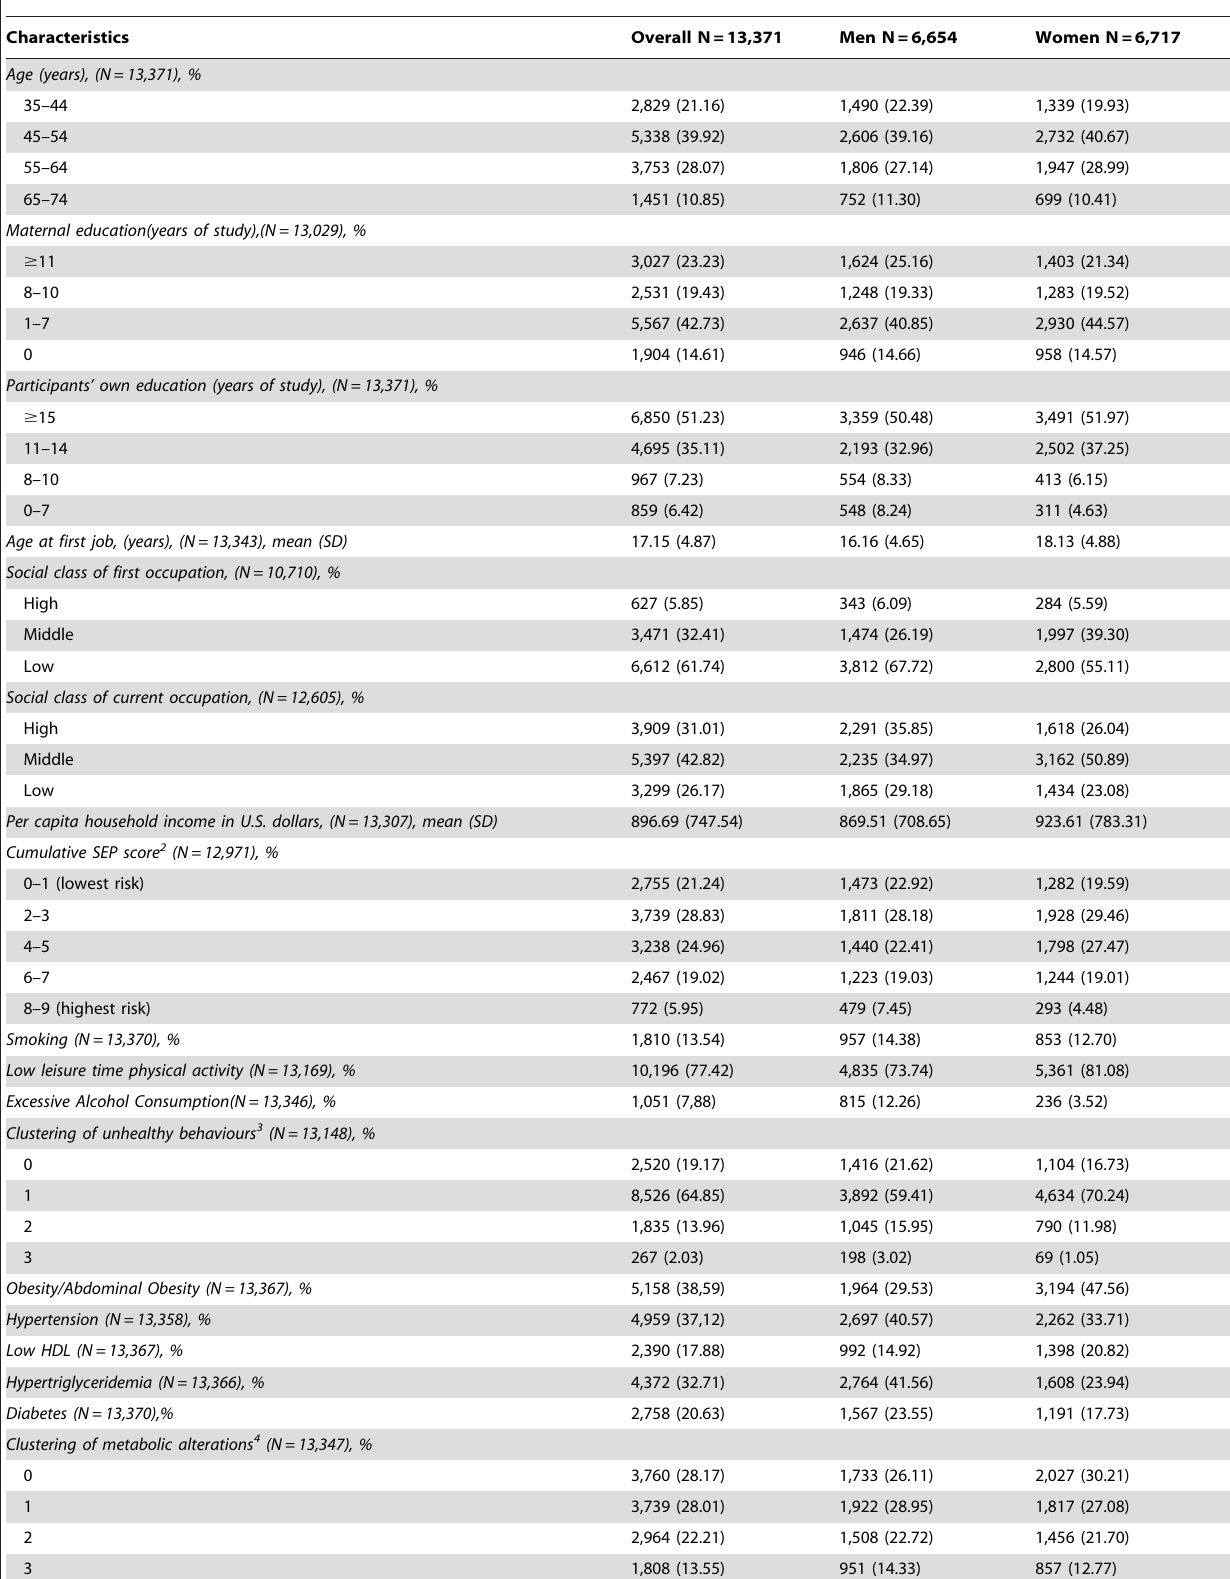
Table 1. Descriptive characteristics of the analytical sample from the Brazilian Longitudinal Study of Adult Health (ELSA-Brasil), N (%) or mean (SD), 2008–2010 (N =13,371) 1